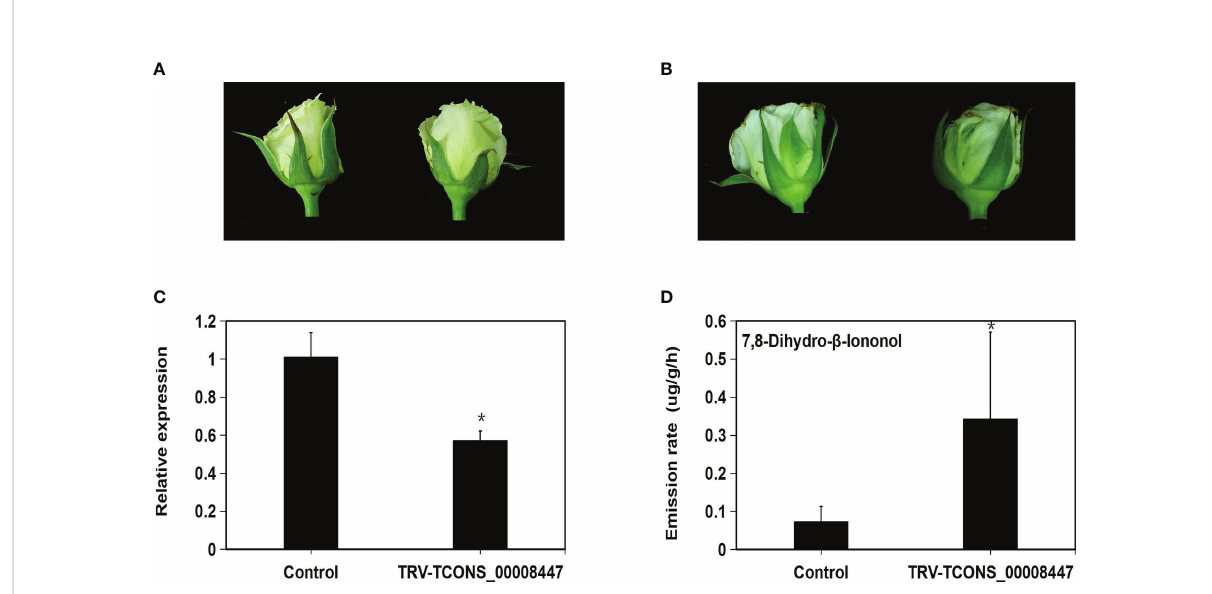
FIGURE 9 Silencing of lncRNA TCONS_00008447 changed the emission of fl oral scent compound. After 6 days, fl owers of rose ‘ Tineke ’ in fi ltrated with TRV-TCONS_00008447 (B) showed a little unfolded and withered compared to TRV control fl owers (A) . (C) qRT – PCR analysis of TCONS_00008447 transcript in TRV control and TRV-TCONS_00008447 fl owers. GAPDH expression values were used for internal reference. (D) Emission variation of 7,8-dihydro- b -ionone in TRV-TCONS_00008447 fl owers compared to TRV control. Error bars indicate ± SD of three biological replicates. Asterisks indicate a signi fi cant difference as determined by Student ’ s t -test (* P